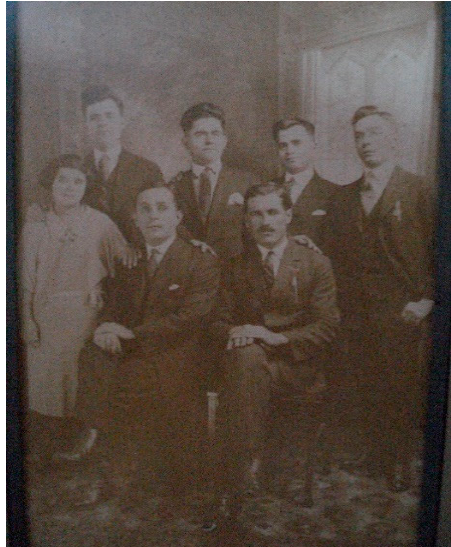
Figure 7. Nickolakis, Kalomoira, Giorgos, Antonis and friends (author’s collection).